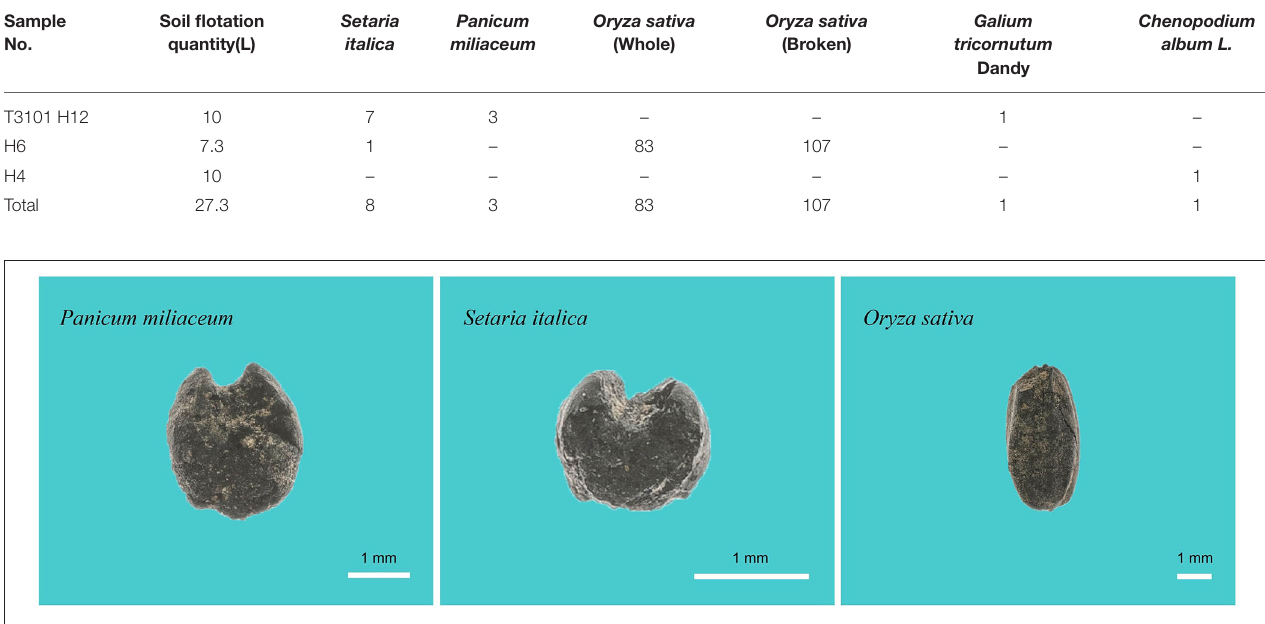
TABLE 3 | Number of identified samples of charred seeds from the flotations at the Jiangxifen site. Sample No.